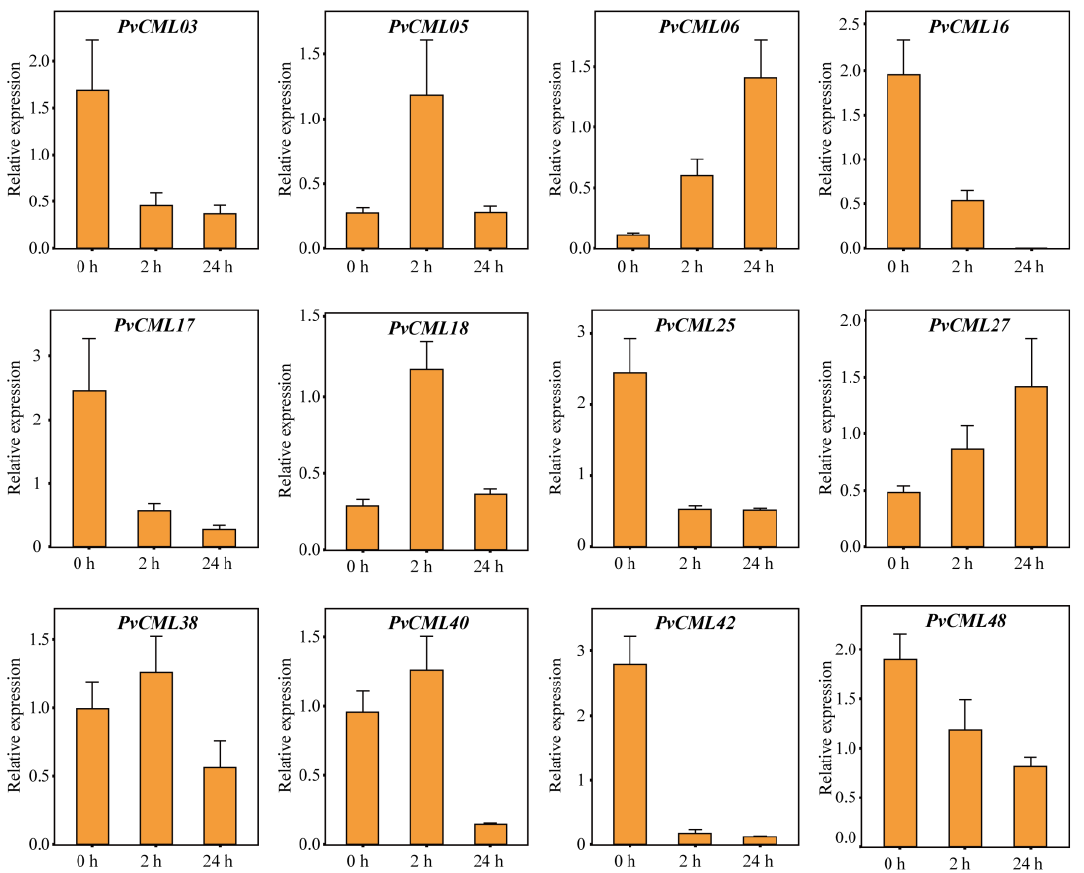
Figure 7. Gene expression analysis by RT – qPCR for the PvCMLs under salt stress conditions. The four-week-old seashore paspalum cultivars (sea spray) were treated with 200 mM NaCl, and three leaves were collected for each sample at 0 h, 2 h, and 24 h following treatment. Three biological replicates were performed for this analysis. The bar plot indicates the relative mRNA expression of each PvCML gene at each treatment time.